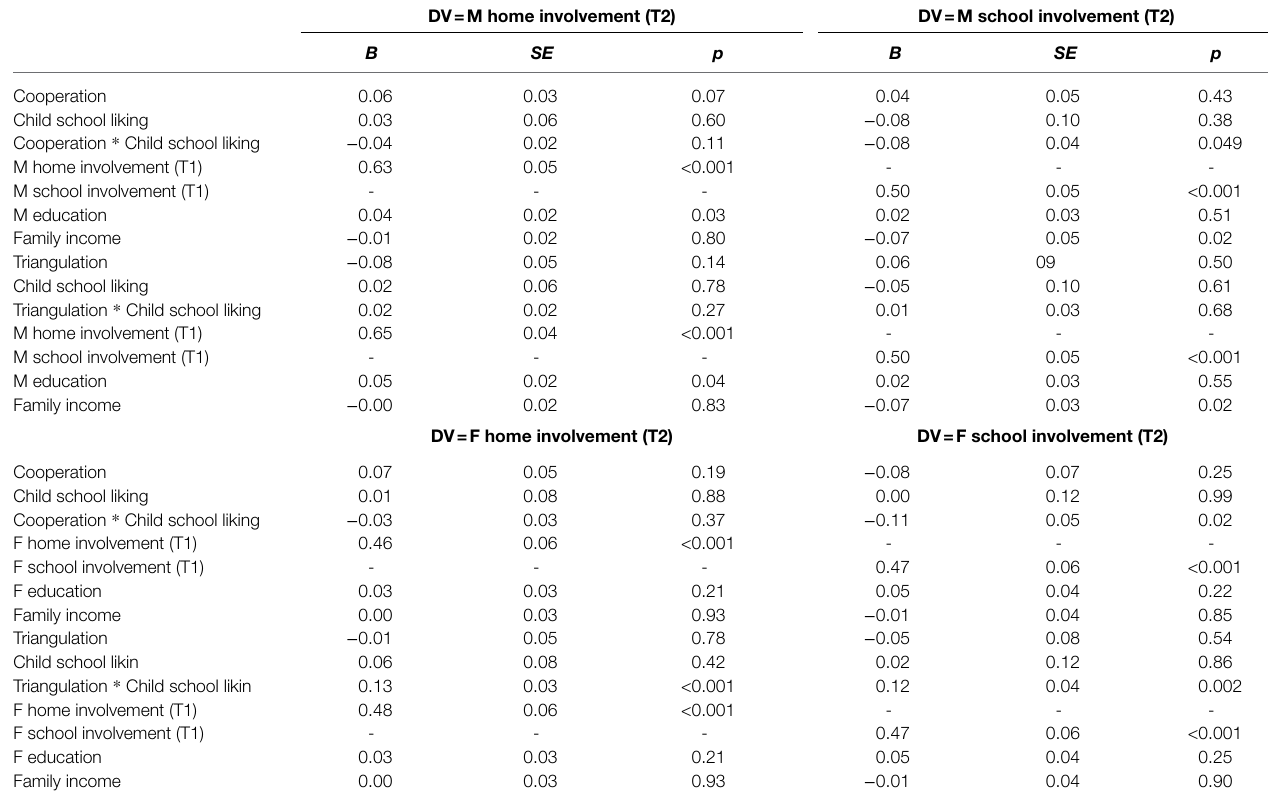
TABLE 2 | The moderating effects of children’s school liking on coparenting and parental